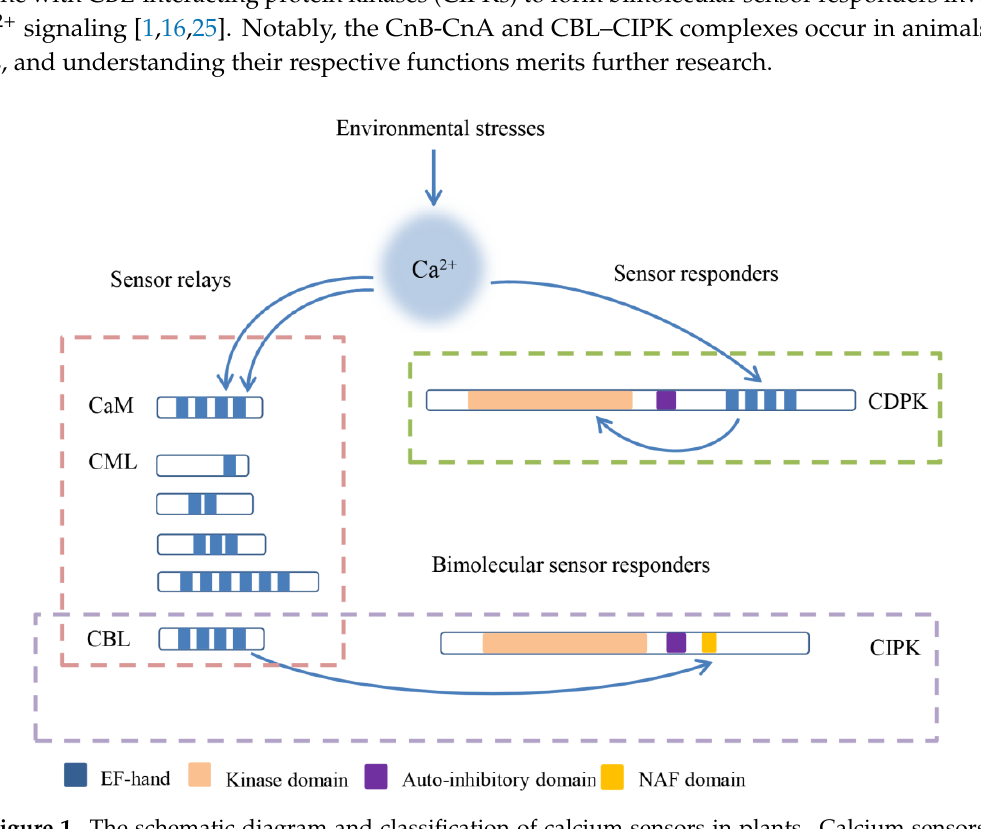
Figure 1. The schematic diagram and classification of calcium sensors in plants. Calcium sensors combine with the Ca 2 + by EF-hand, and then activate the binding proteins or themselves to regulate the downstream. calmodulins (CaMs), CaM-like proteins (CMLs), and calcineurin B-like proteins